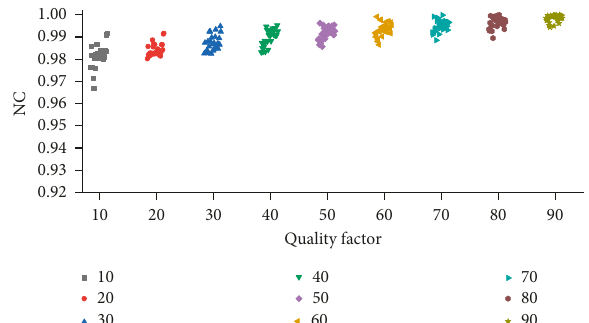
Figure 10: NC value under JPEG compression attack.